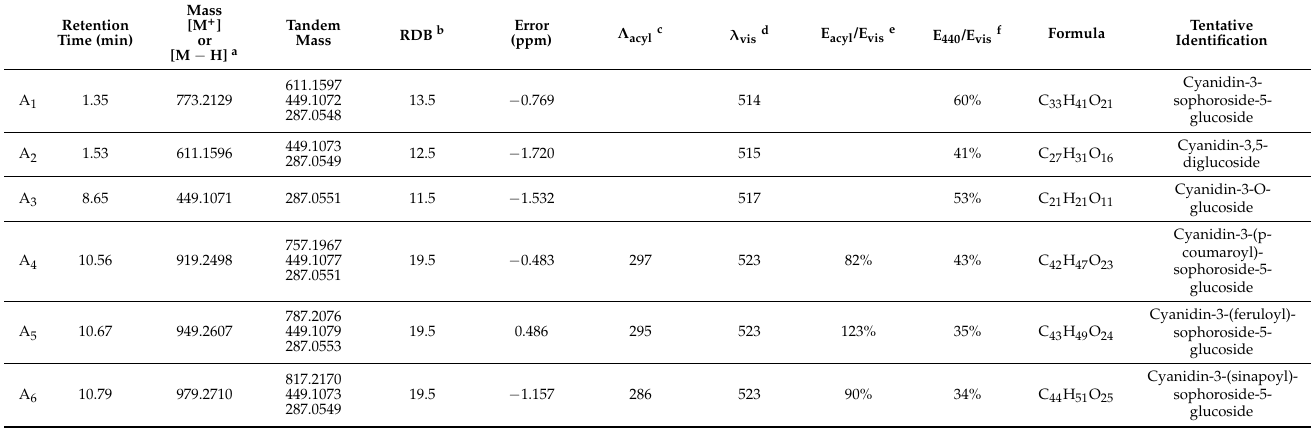
Table 1. Anthocyanins and phenolics tentatively identified in the Brassica oleracea L. var. capitata f. rubra DC (red cabbage) leaves using high resolution UPLC-PDA-MS/MS in positive and negative ionization mode. Retention